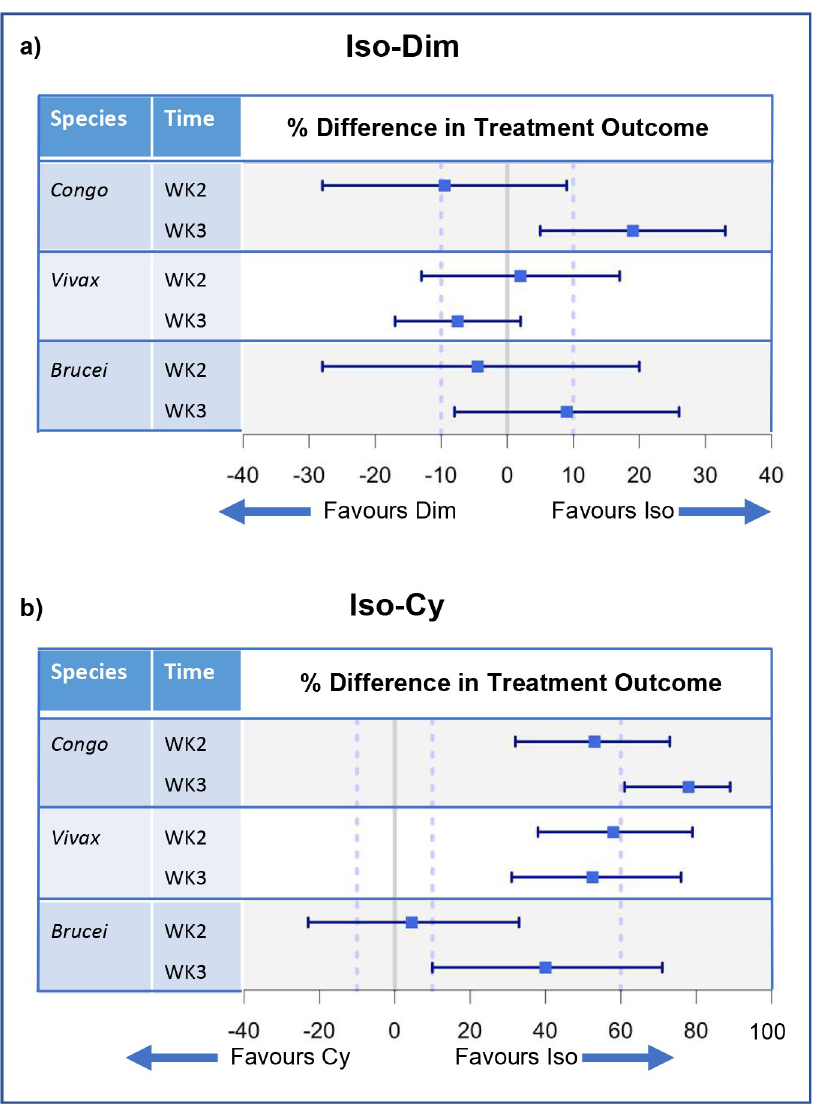
Fig 5. Forest plots illustrating non-inferiority analysis of the outcome of trypanocidal treatment by Trypanosoma spp.. Trypanosoma spp. PCR status was used as the outcome variable. The control drug (Iso = isometamidium) was compared to test drugs (Dim = diminazene (a) and Cy = melarsomine dihydrochloride (b)) for each infective species of Trypanosoma spp. at each time point (week 2 and 3). Positive treatment outcome was defined as a negative PCR result. The percentage difference in treatment outcome is presented as a point estimate (blue square) and two sided 95% confidence intervals (blue bars). Results are divided by Trypanosoma spp. ( Brucei = T . brucei sp. ; Congo = T . congolense; Vivax = T . vivax ) and time point (week 2 and week 3). The 10% line represents M2, the accepted difference between drugs to demonstrate non-inferiority. The 60% line represents M1, the accepted difference between the control drug and the test drug to demonstrate placebo effect. a) Isometamidium (control drug) is compared to diminazene (test drug) b) Isometamidium (control drug) is compared to melarsomine dihydrochloride (test